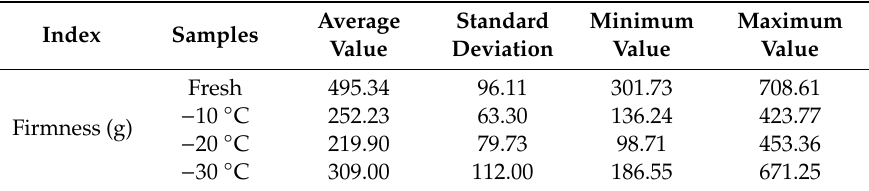
Table 10. Firmness values of the Nanguo pears.